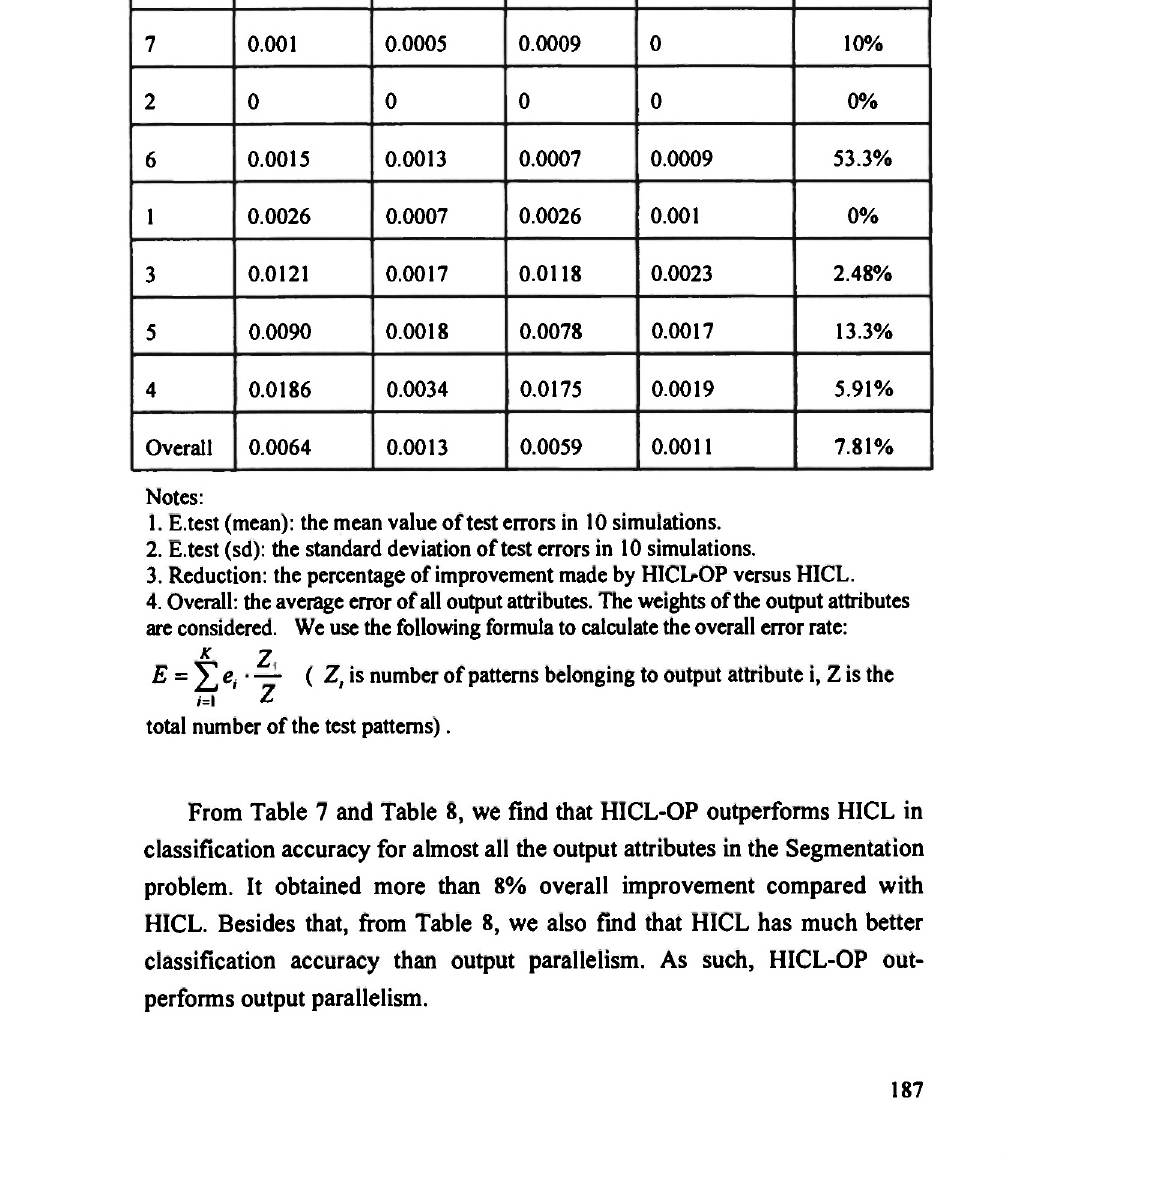
The comparison of test errors for the Segmentation